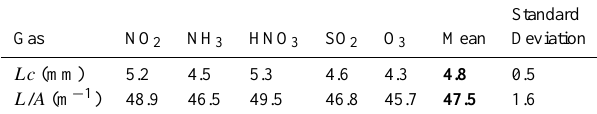
Table 4. Synthesis of L / A and Lc experimental determination (Al- Ourabi,